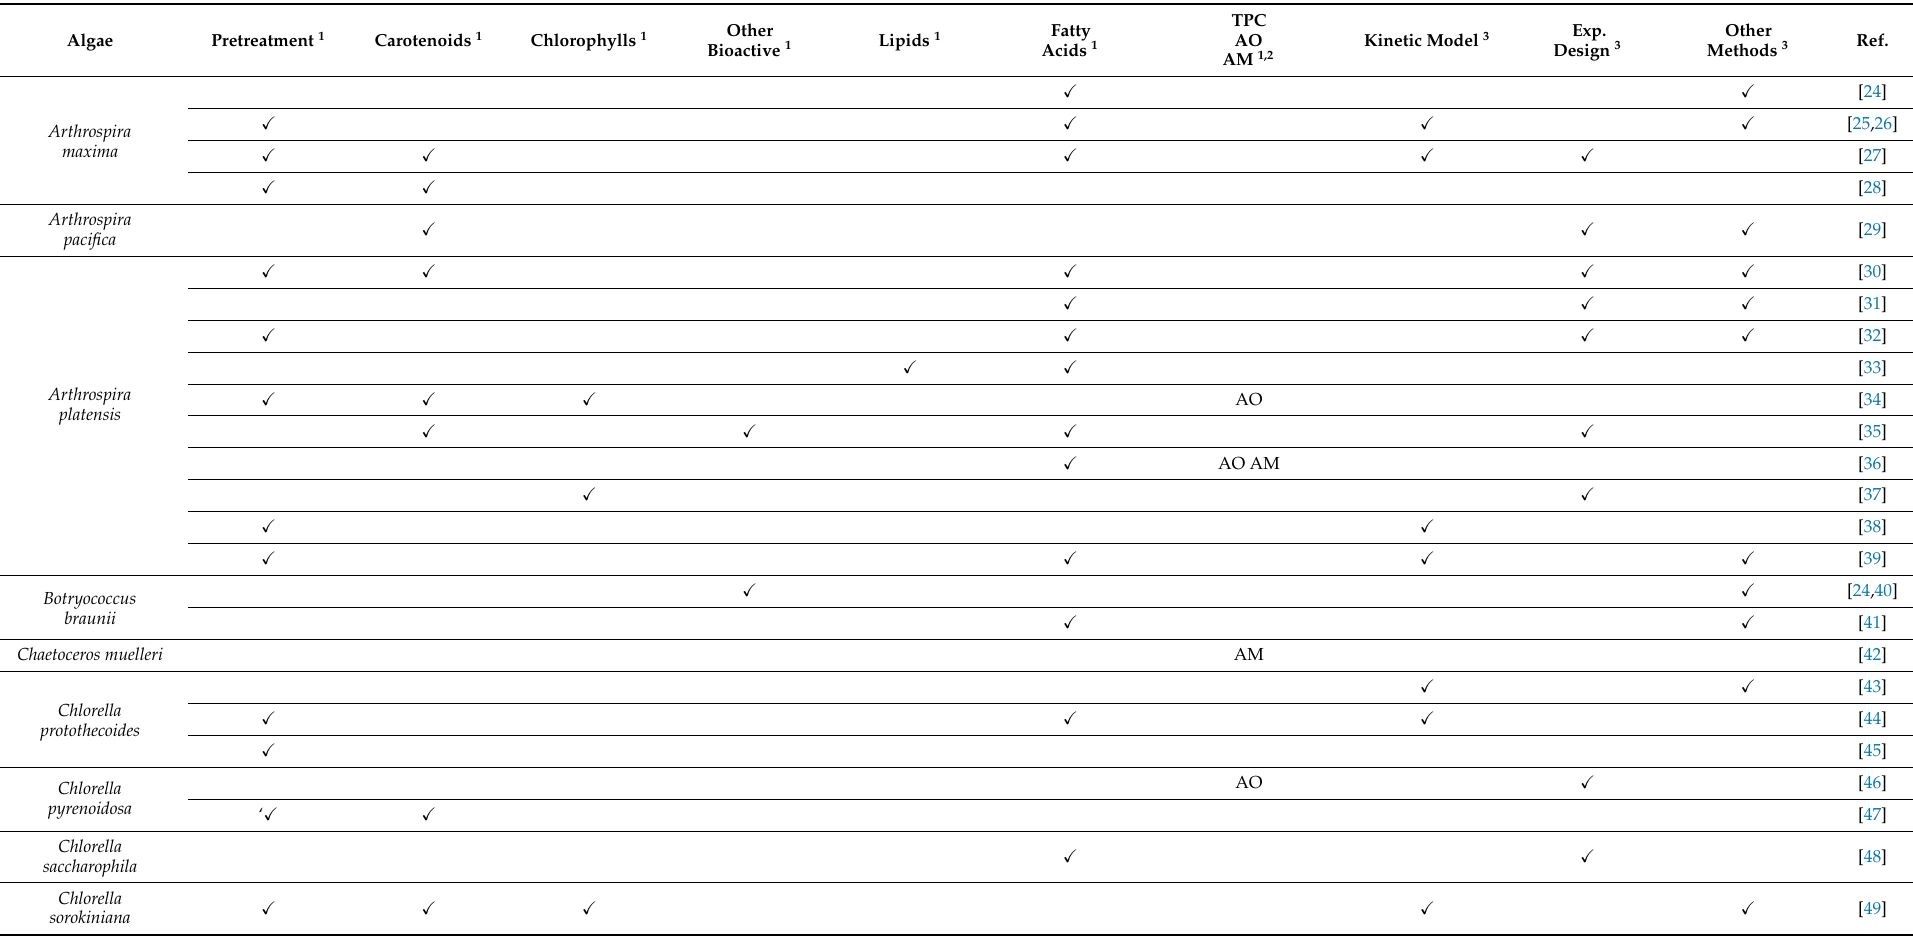
Table 1. Microalgal species and literature data mentioned in this